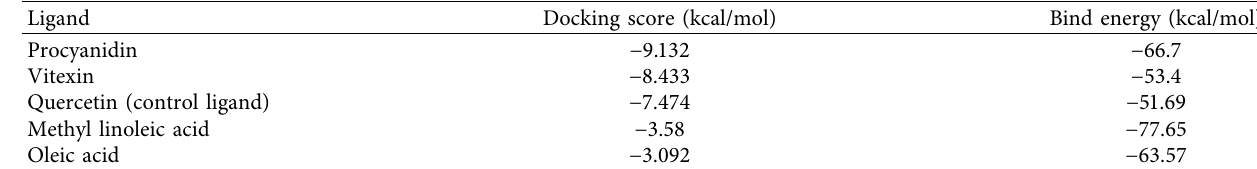
Table 5: Docking scores and MM-GBSA binding free